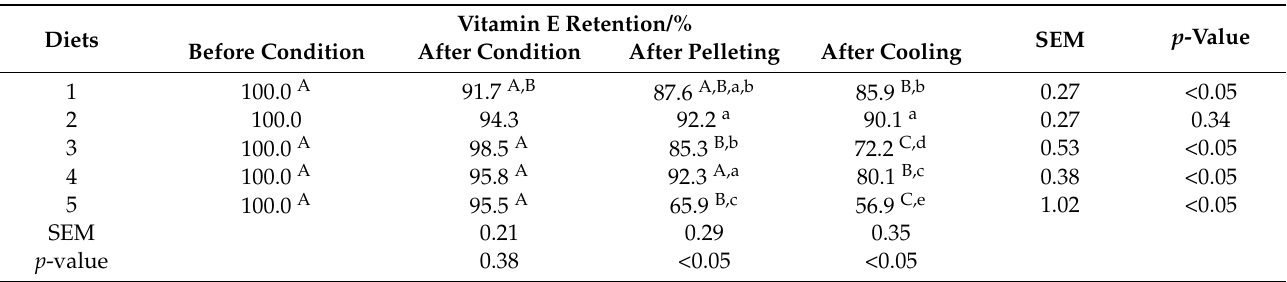
Table 5. The retention of vitamin E in diets during pelleting and the long-term high-temperature stabilization process.